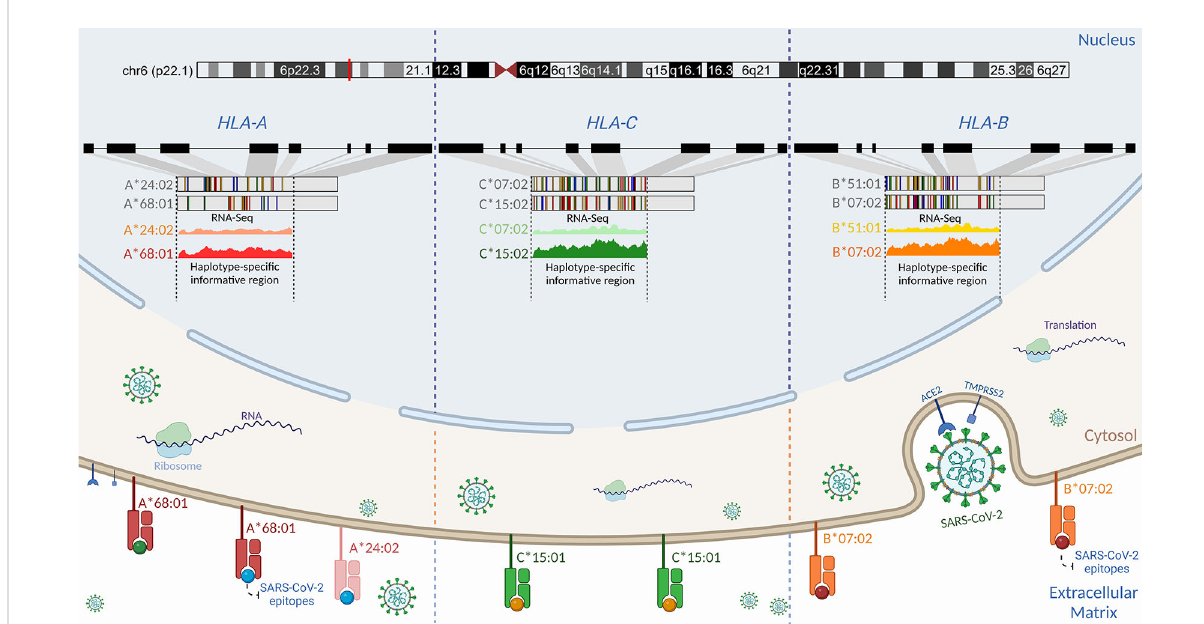
FIGURE 5 Schematic representation of the proposed regulatory genetic mechanism associated with the haplotype-speci fi c expression of class I HLA alleles during SARS-CoV-2 infection. Viral cell entry triggers preferential transcription of the RNA molecules in the classical class I HLA locus. Even though Calu-3 is heterozygous for HLA-A , -B , and -C alleles (79), we found that the A*68:01 allele was more expressed than the A*24:02 allele, the B*07:02 allele was more expressed than the B*51:01 allele, and the C*15:02 allele was more expressed than the C*07:02 allele. Such differences in the expression may be attributed to structural differences in promoter motifs (80), transcriptional factors, genetic variations, and environment (81, 82). Cross-referencing analysis using HLA peptidome data from Calu-3 infected by SARS-CoV-2 generated by Nagler and colleagues (2021) revealed that the same RNA molecule found to be preferentially expressed in RNA-Seq data corresponds to the HLA protein expressed on the cell surface for classical class I alleles. Nagler and colleagues (2021) reported that most peptides presented on the cell surface matched the A*68:01 allele when compared to the A*24:02. For HLA-C , no peptide matching C*07:02 was found after infection. Similarly, the B*07:02 allele was found to be preferentially expressed at the HLA-B locus. By using DASE, swapping alleles with low binding af fi nity could be a part of the defense that helps COVID-19 outcomes be less severe. Created with